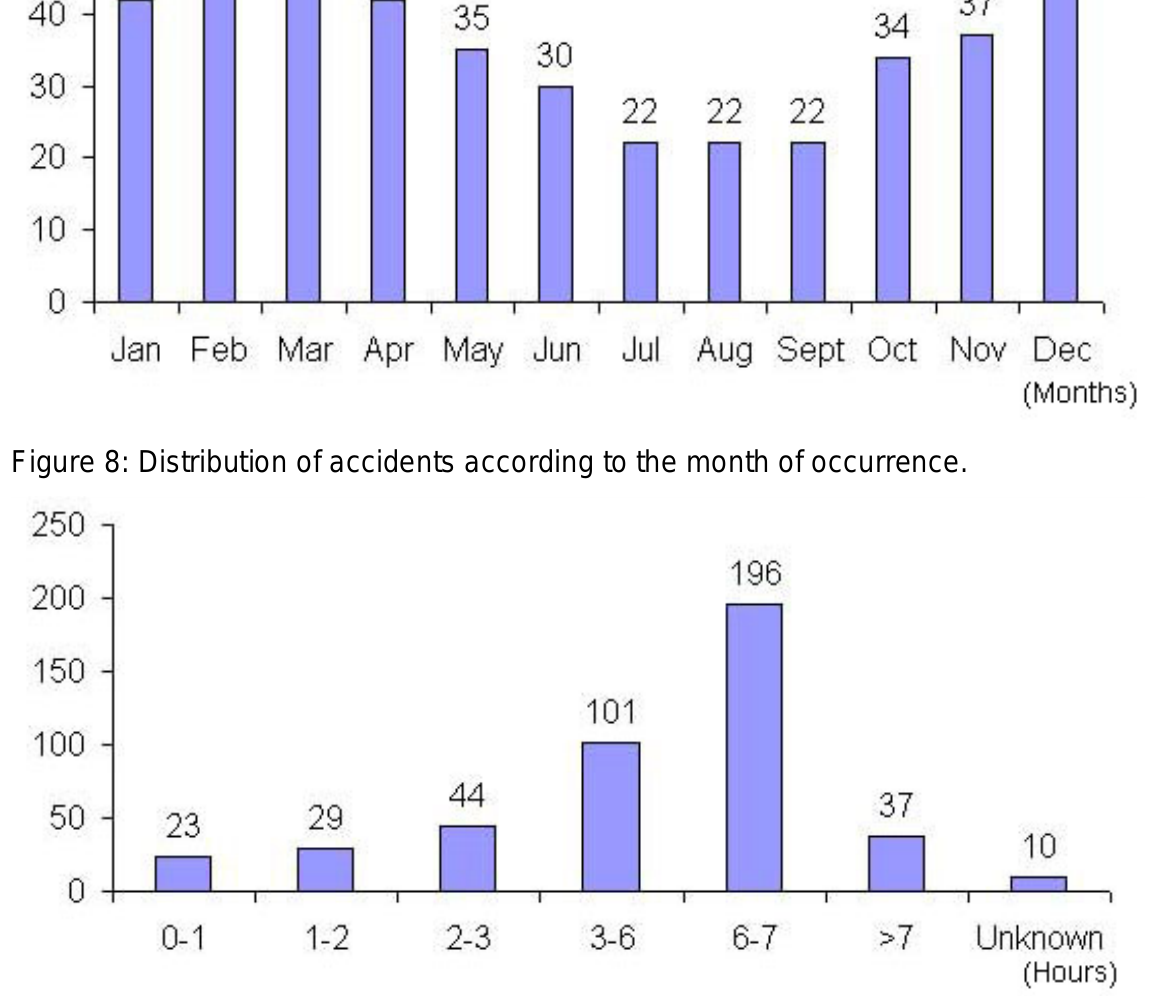
Figure 9: Distribution of accidents according to the time elapsed between the bite and the medical